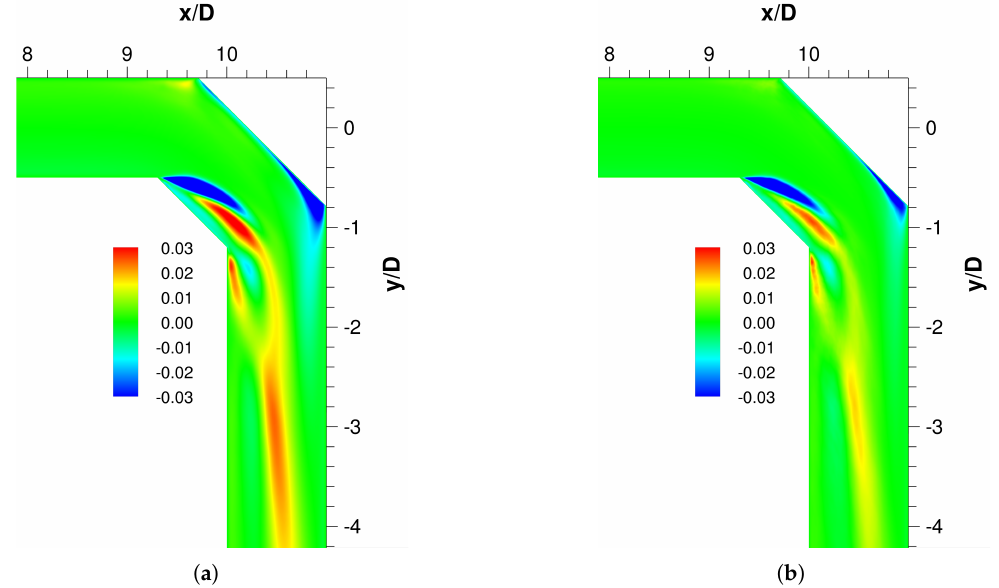
Figure 16. Time-averaged dimensionless Reynolds shear stress (cid:104) u (cid:48) v (cid:48) (cid:105) / U 2 plane at z / D = 0. ( a ) Re L . ( b ) Re H